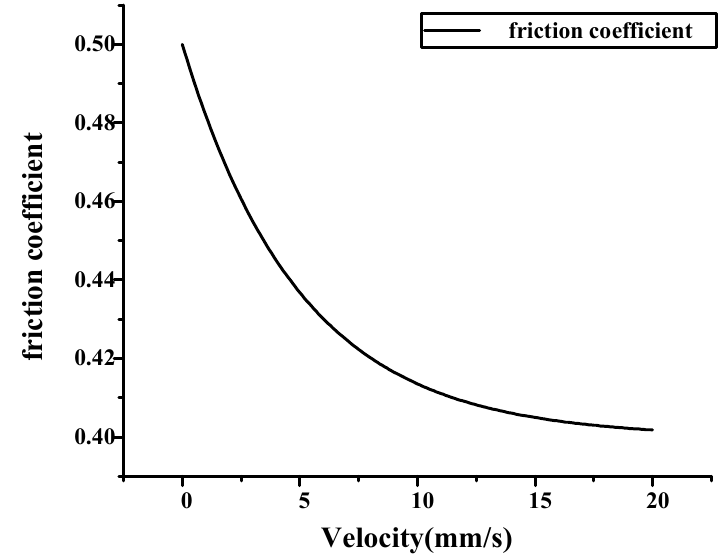
Figure 27. Friction model with exponential decay.